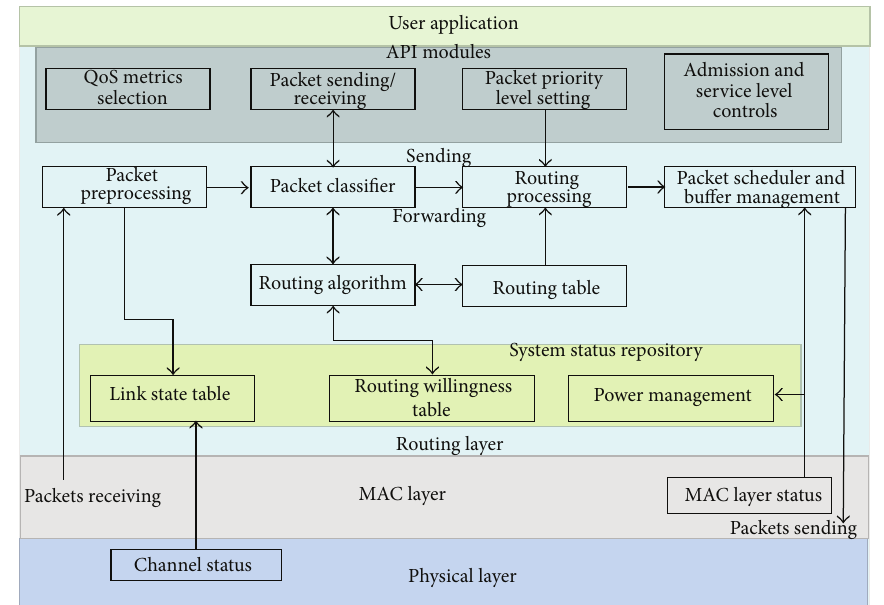
Figure 9: Framework of QoS-aware routing protocol (redrawn from